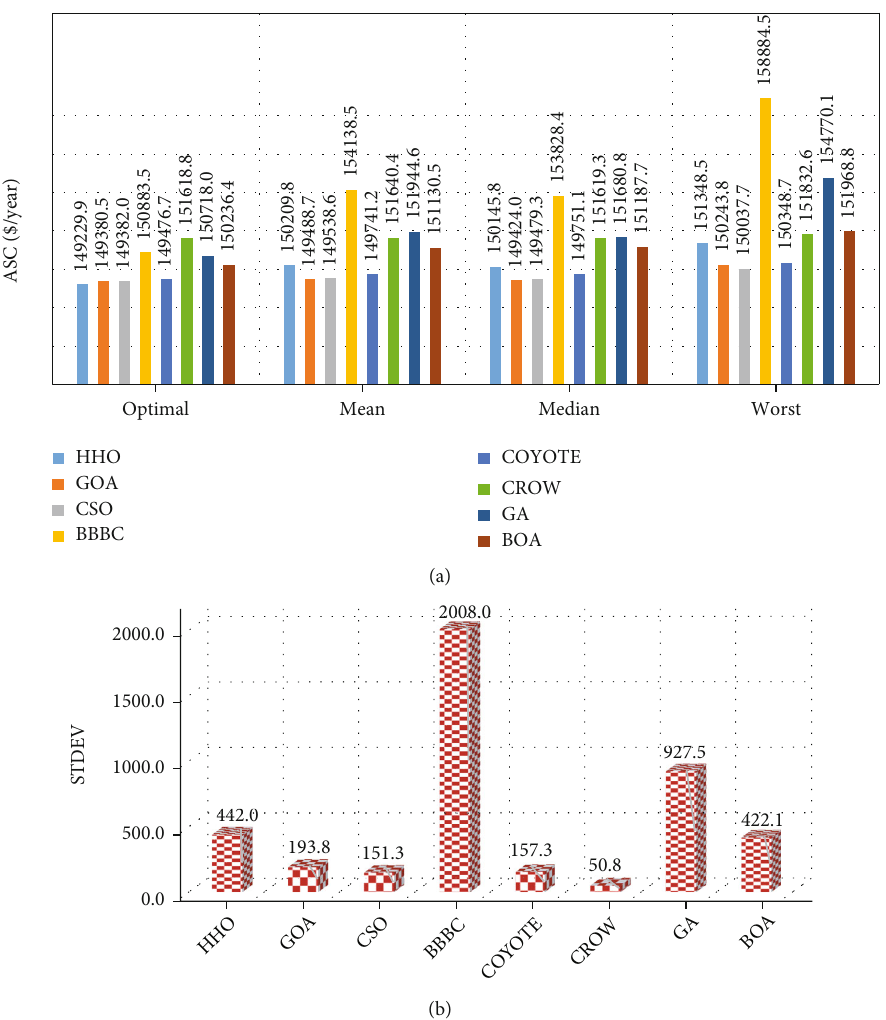
Figure 6: The fi ve-performance metrics: (a) optimal, worst, median, and mean and (b)